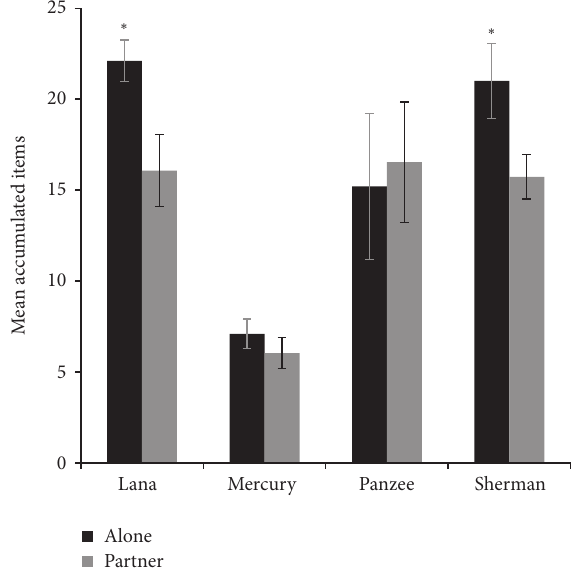
F 1: Accumulation performance as a function of the pres- ence�absence of a conspeci�c working independently on the same test type in an adjacent enclosure. Error bars represent Standard Error of the Mean. An asterisk above a pair of bars represents a signi�cant difference between